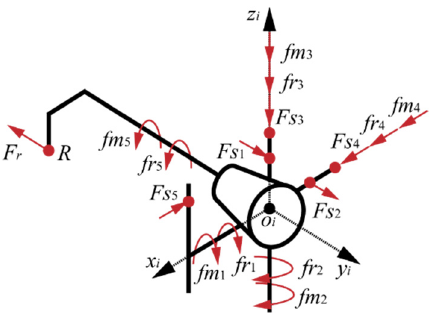
Figure 12. Free-body diagram of the resetting conditions of the drogue.